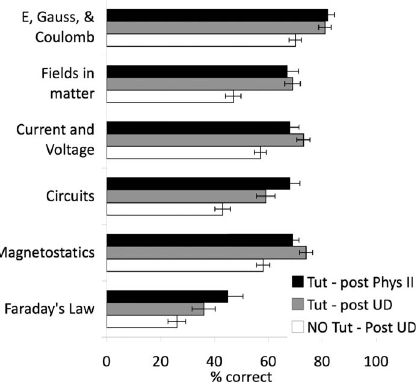
FIG. 3. Comparison of performance on subgroups of BEMA questions. For each of six clusters of BEMA questions, we show the scores of N =49 individuals for whom we have matched data from Physics II and upper-division (cid:1) We average post-301 and post-302 scores for individual students when both scores are available (cid:2) (cid:1) White bars, consists of N =101 individuals, who had never taken freshman Tutorials. We have no freshman-level BEMA data for this population. (cid:2) Cluster definitions are: E-field, Gauss’ law, Coulomb’s law (cid:1) BEMA questions 1–6 and 18 (cid:2) . Fields in matter (cid:1) BEMA 7,12,19 (cid:2) . Current and Voltage (cid:1) BEMA 8,9, 13–16 (cid:2) . Circuits (cid:4) BEMA 10,11,17, and ECCE questions 10–12 (cid:1) Ref. 27 (cid:2)(cid:5) . Magnetostatics (cid:1) BEMA 20–27, 30 (cid:2) . Faraday’s Law (cid:1) BEMA 28, 29, 31 (cid:2)